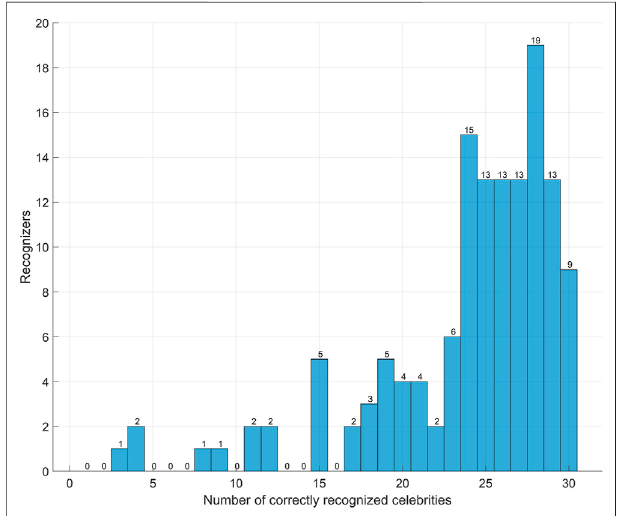
FIGURE 4 | Histogram of the number of correctly recognized celebrities achieved by all